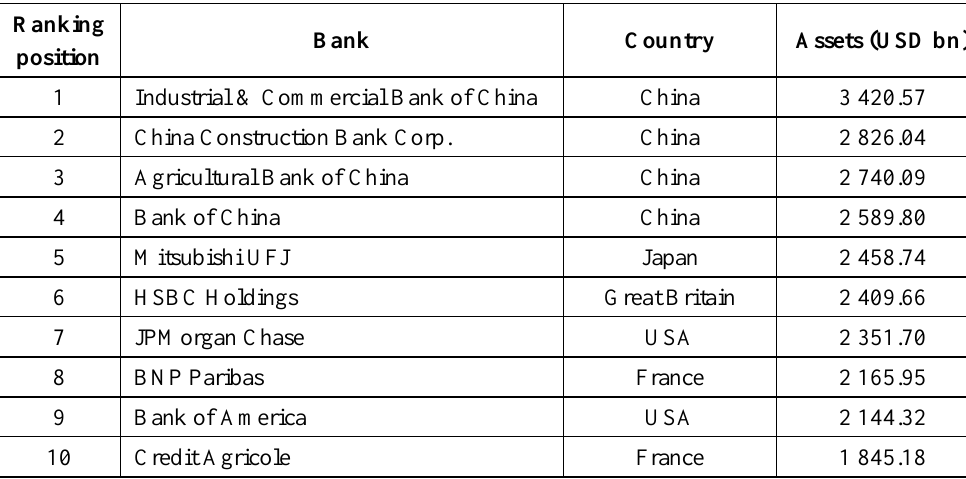
Table 1. The world’s largest